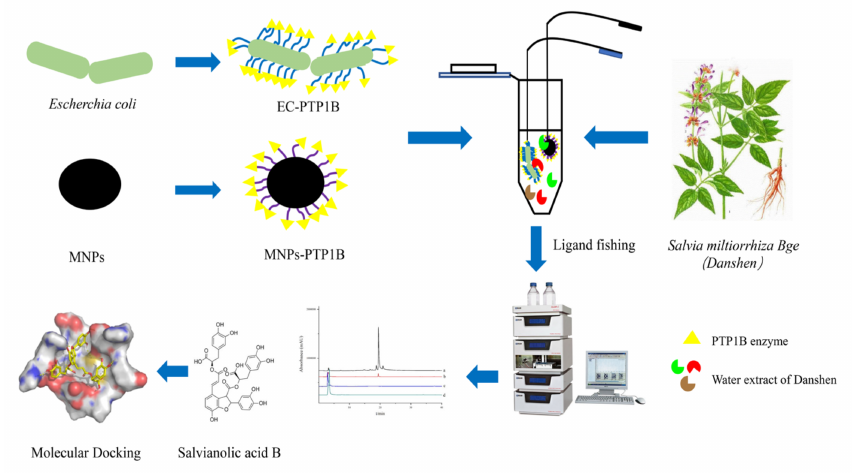
Figure 1. Flow chart of screening PTP1B inhibitors from S . miltiorrhiza